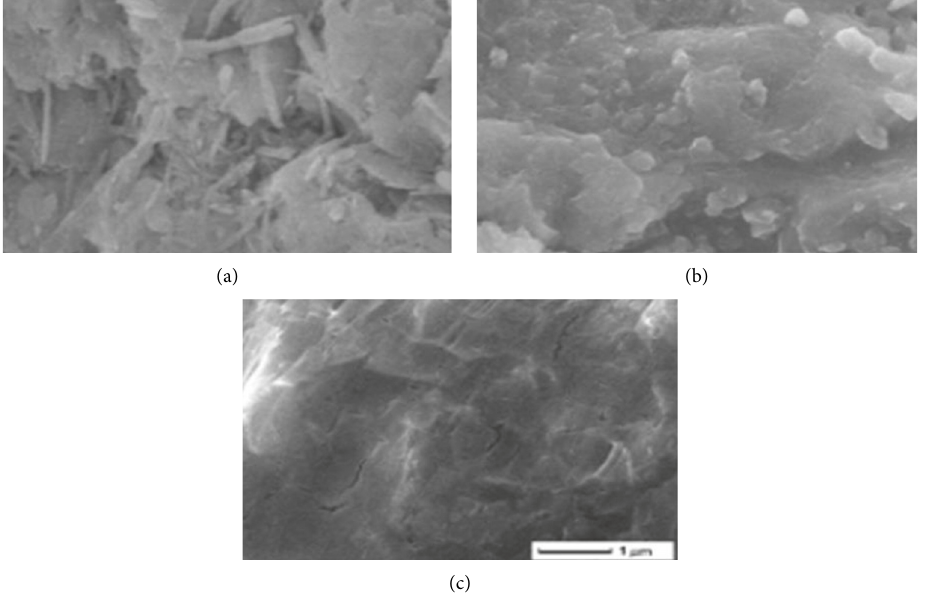
Figure 2: (a) SEM image of activated dolomite (AC), (b) SEM image of ZnO doped on activated clay (ZD), and (c) SEM image of SnO doped on activated clay